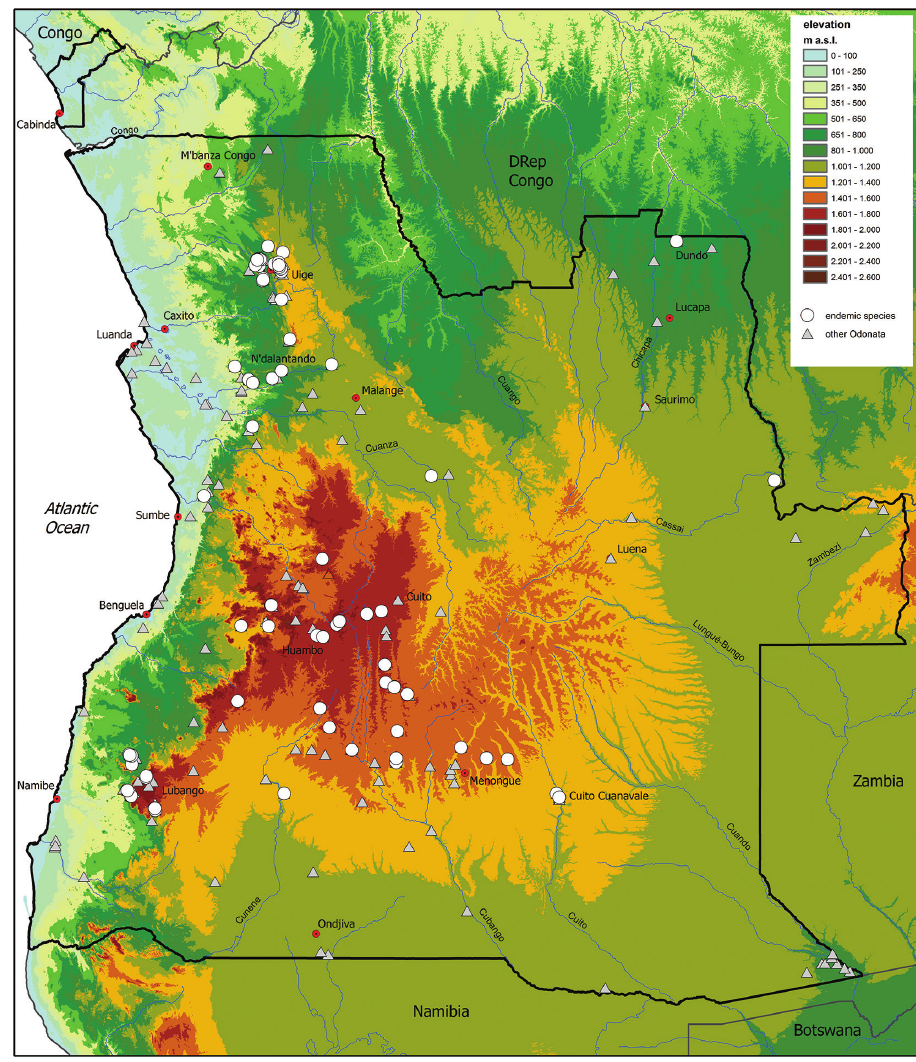
Figure 3. Records of 16 endemic Odonata species in Angola relative to altitude. White dots: endemic species (marked ** in Table 1); grey triangles: other species. Elevation follows the GTOPO30 model of the U.S. Geological Center for Earth Resources Observation and Science